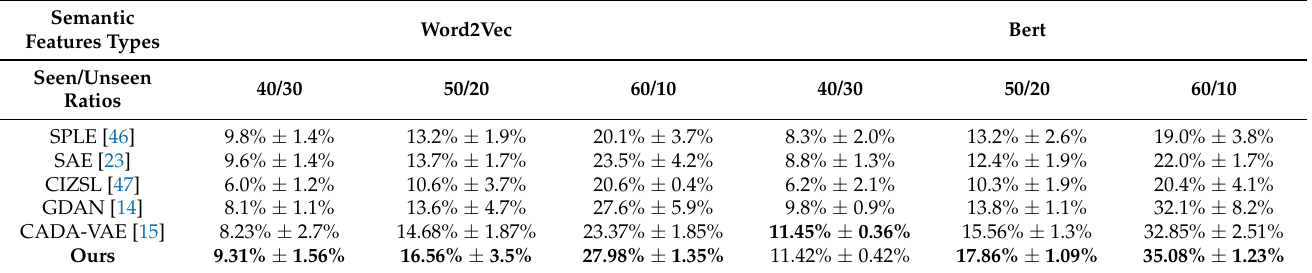
Table 1. The results of the comparison with related zero-shot